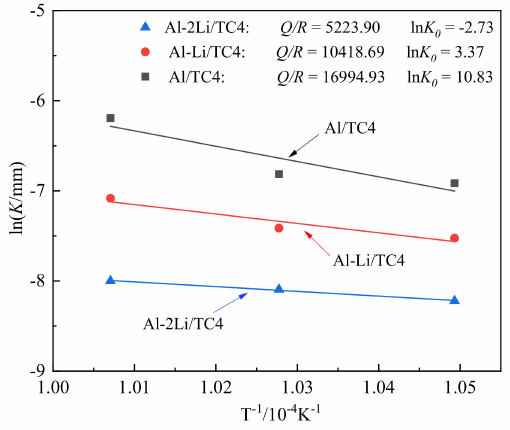
Figure 6. Temperature dependence of K for TC4 in liquid Al–xLi